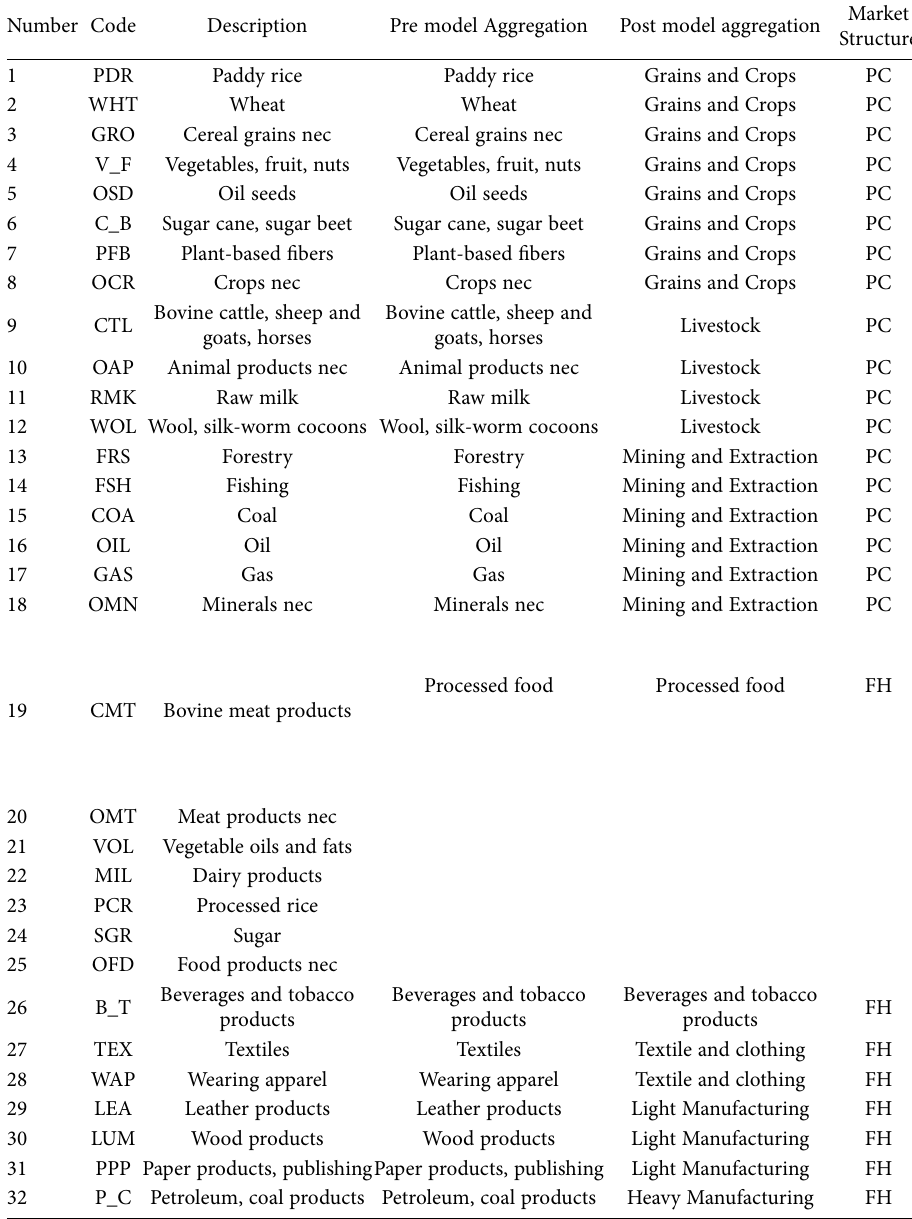
Table A1. Sectoral correspondence of GTAP 9 sector to new